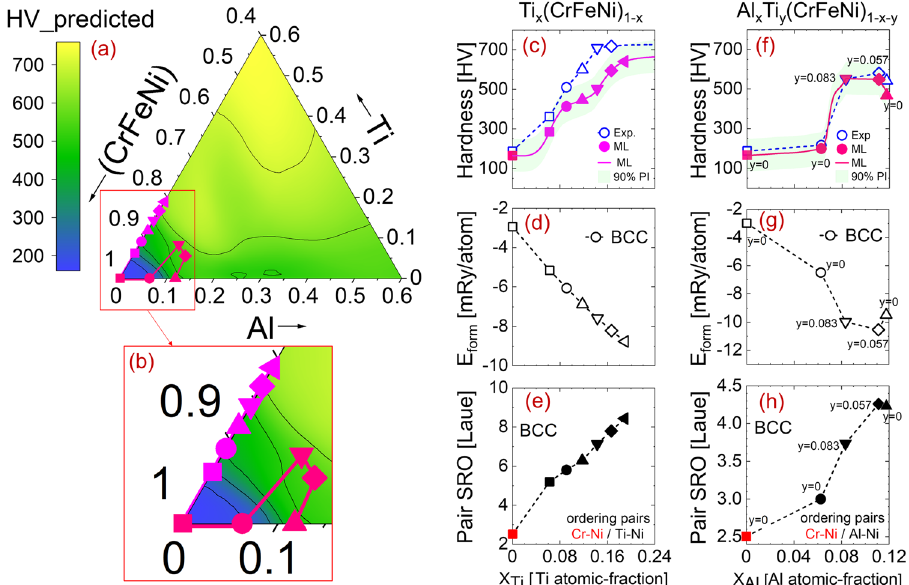
Fig. 3 ML predictions of hardness and corresponding formation enthalpy and SRO obtained from DFT calculations. a Predicted hardness contours for Al x Ti y (CrFeNi) 1- x - y . b Inset shows the hardness contours in Al-poor and Ti-poor regions, along with composition trajectories along which hardness measurements and predictions are compared. c Experimental and ML-predicted hardness for Ti x (CrFeNi) 1- x with a 90% prediction-interval (PI). d Formation energy of the BCC MPEA and e Pairwise SRO in Ti x (CrFeNi) 1- x . f Experimental and ML-predicted hardness for Al x Ti y (CrFeNi) 1- x - y with a 90% prediction-interval (PI). g Formation energy of the BCC solid solution and h Pair SRO and dominant ordering pairs in Al x Ti y (CrFeNi) 1- x - y